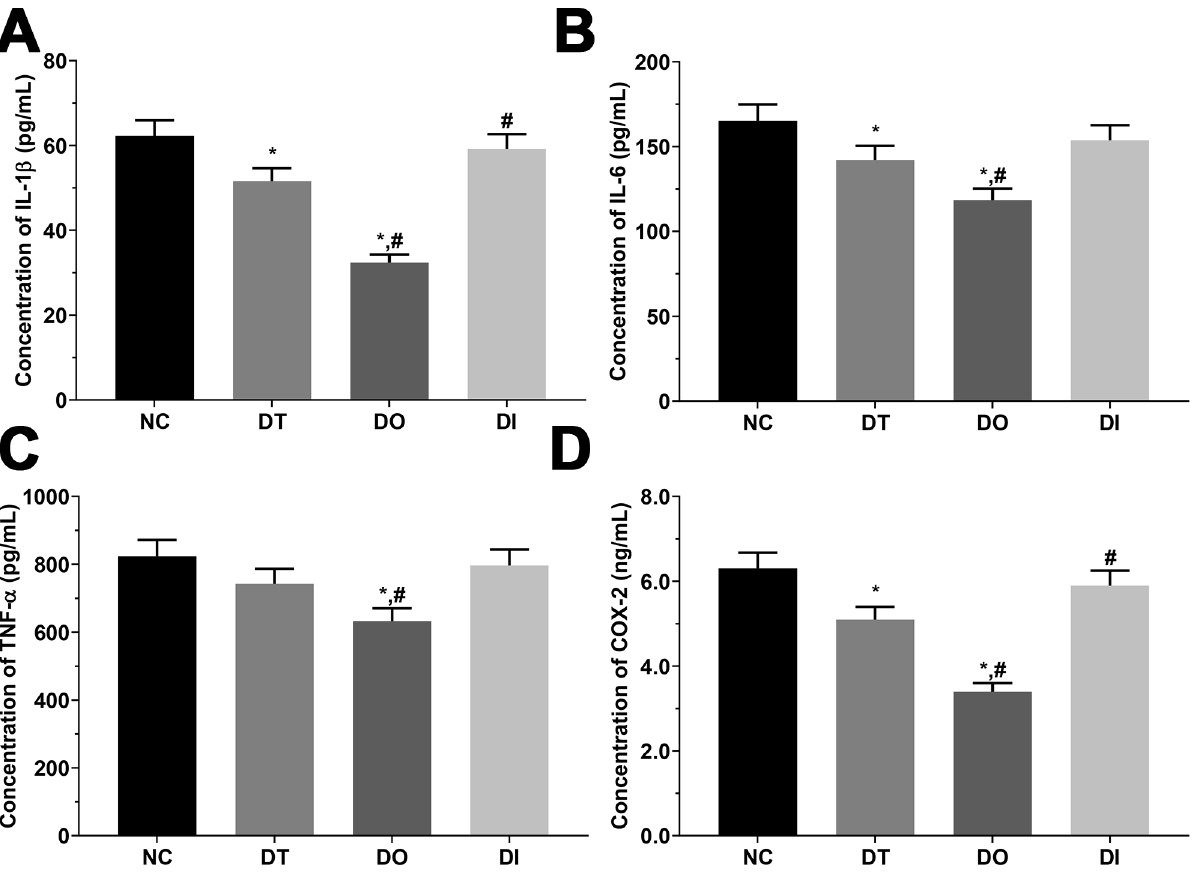
Figure 9 – Concentration of pro-inflammatory factor in cultured medium of glial cells. (A) Concentration of IL-1β mRNA in NC, DT, DO and DI group of glial cells. (B) Concentration of IL-6 mRNA in NC, DT, DO and DI group of glial cells. (C) Concentration of TNF-α in NC, DT, DO and DI group of glial cells. (D) Concentration of COX-2 in NC, DT, DO and DI group of glial cells. Data was presented as mean ± SD, each experiment was repeated for three times. *P<0.05 vs NC group of cells. #P<0.05 vs signal dezocine treatment group. NC: normal group, DT: dezocine treatment group, DO: dezocine treatment combined with RAPGEF3 overexpression group, DI: dezocine treatment combined with RAPGEF3 inhibition group. SH: sham group, TD: dezocine treatment group, TO: dezocine treatment combined with RAPGEF3 overexpression group, TI: dezocine treatment combined with RAPGEF3 inhibition